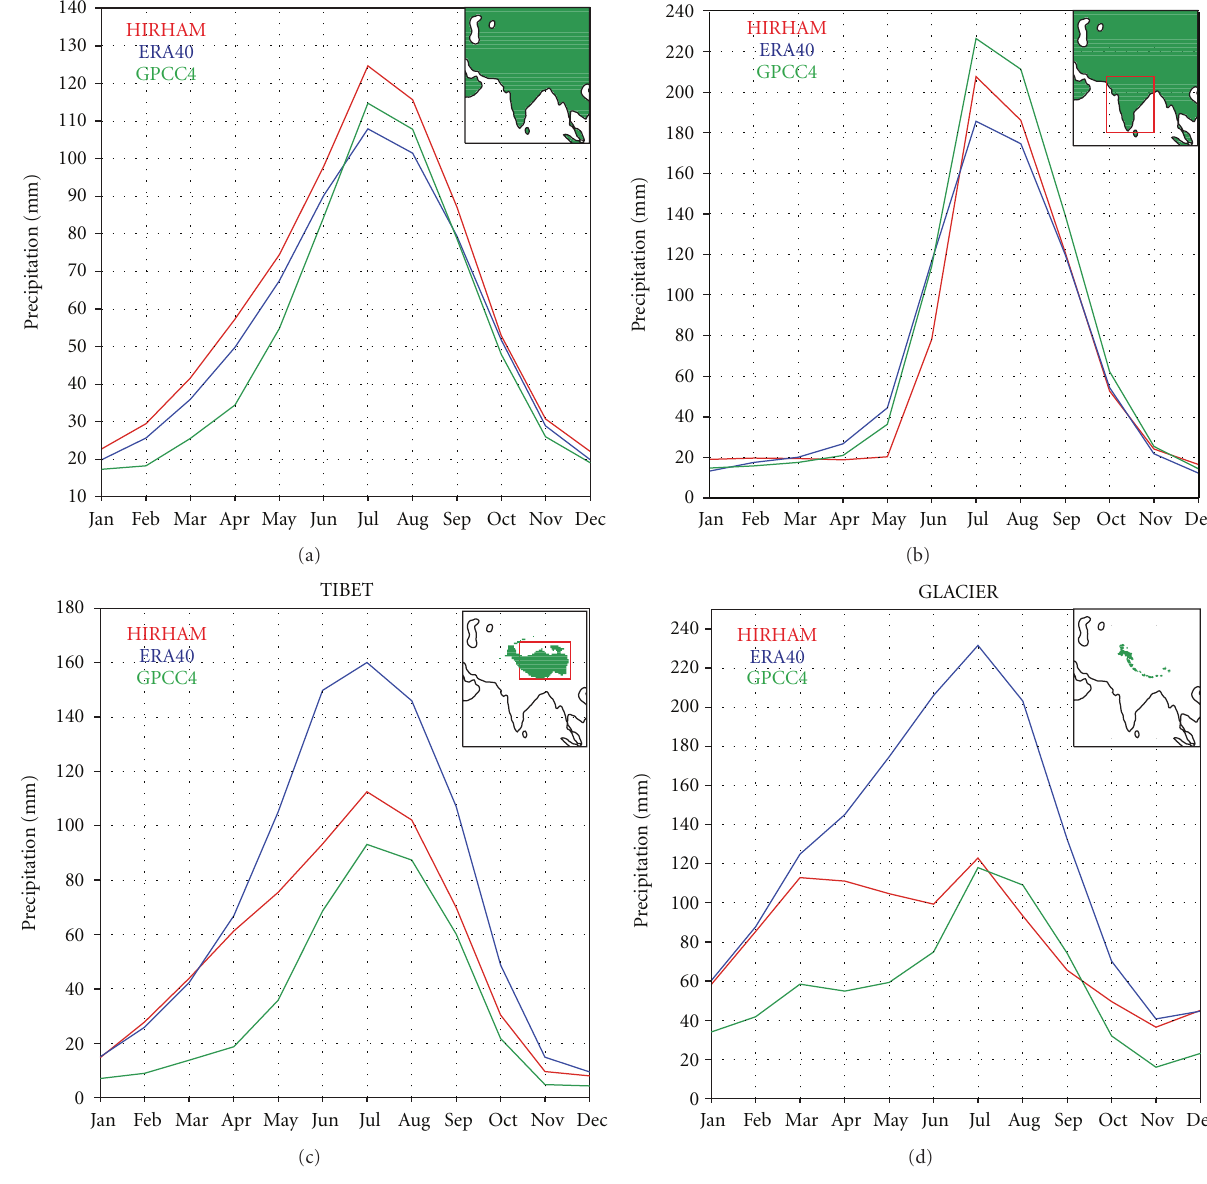
Figure 9: Mean annual cycles of precipitation (mm) 1958–2001 for HIRHAM (red), ERA40 (blue), and GPCC4 (green) in selected